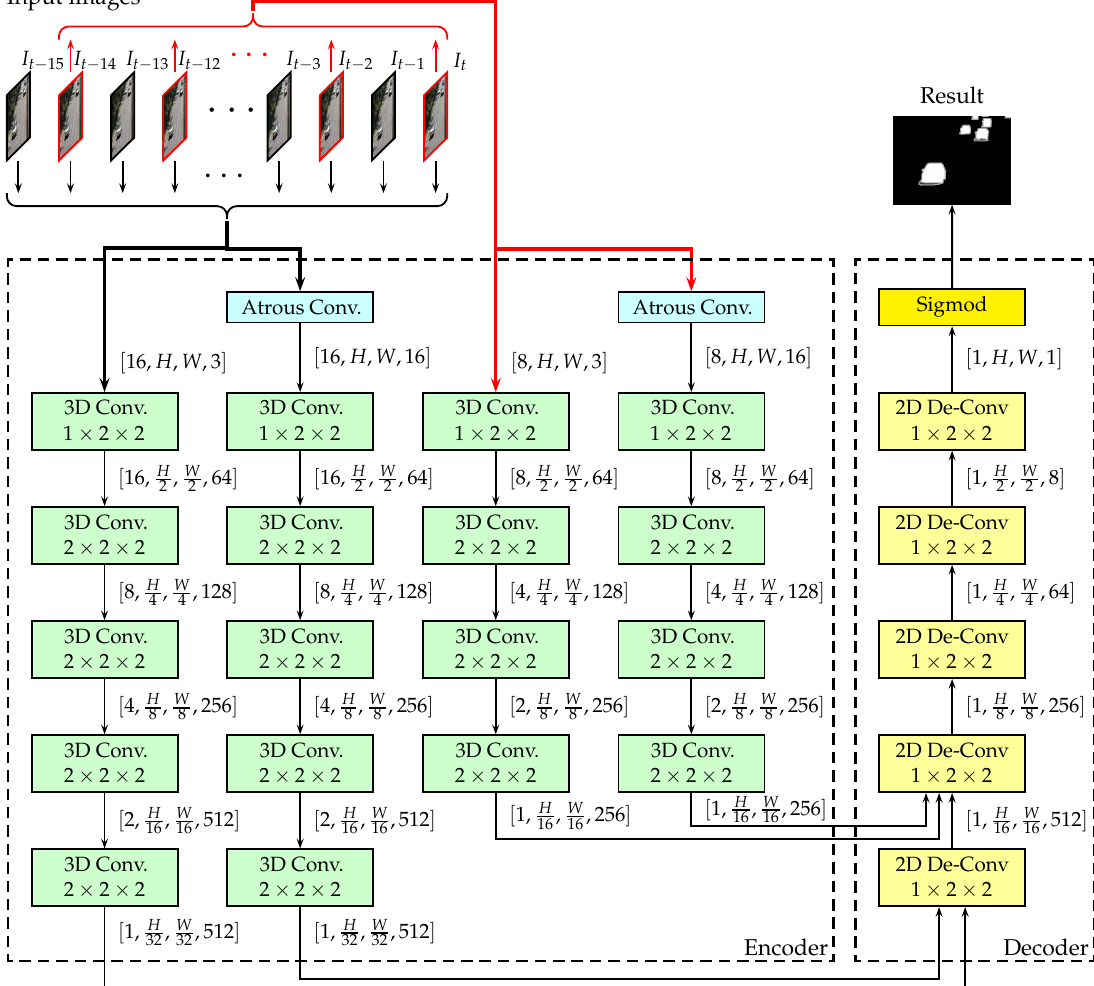
Figure 1. The architecture of the proposed network. (The downsampling rate or the upsampling rate are shown in each layer. The dimensions of the tensors are shown beside corresponding arrows.)